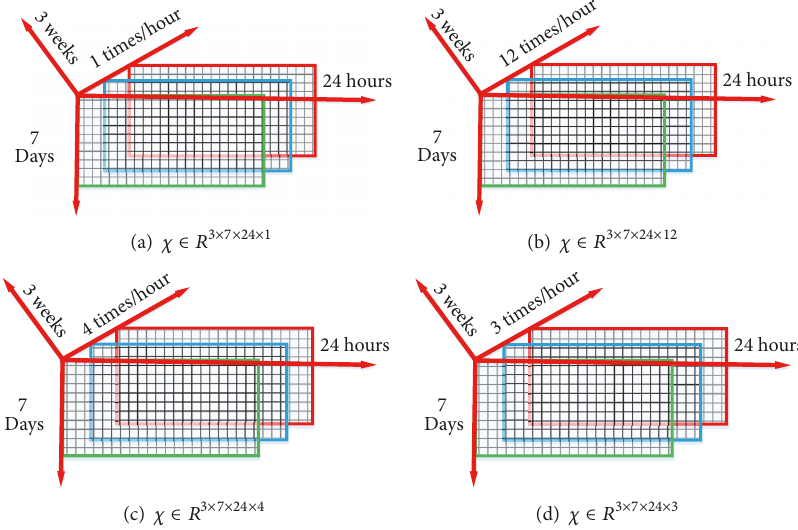
Figure 3: Four tensor models with different combinations of traffic